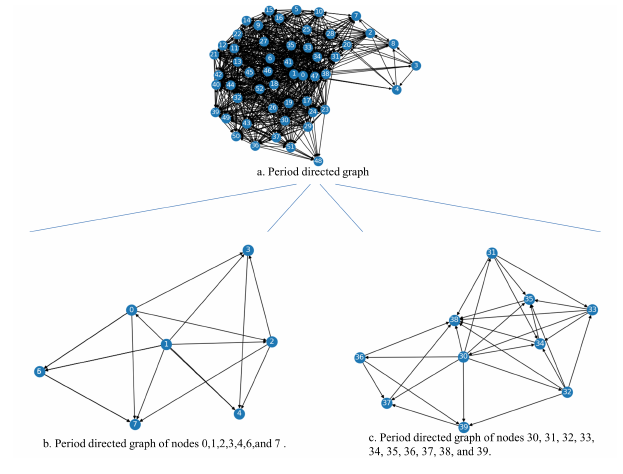
Figure 12. Period structure.